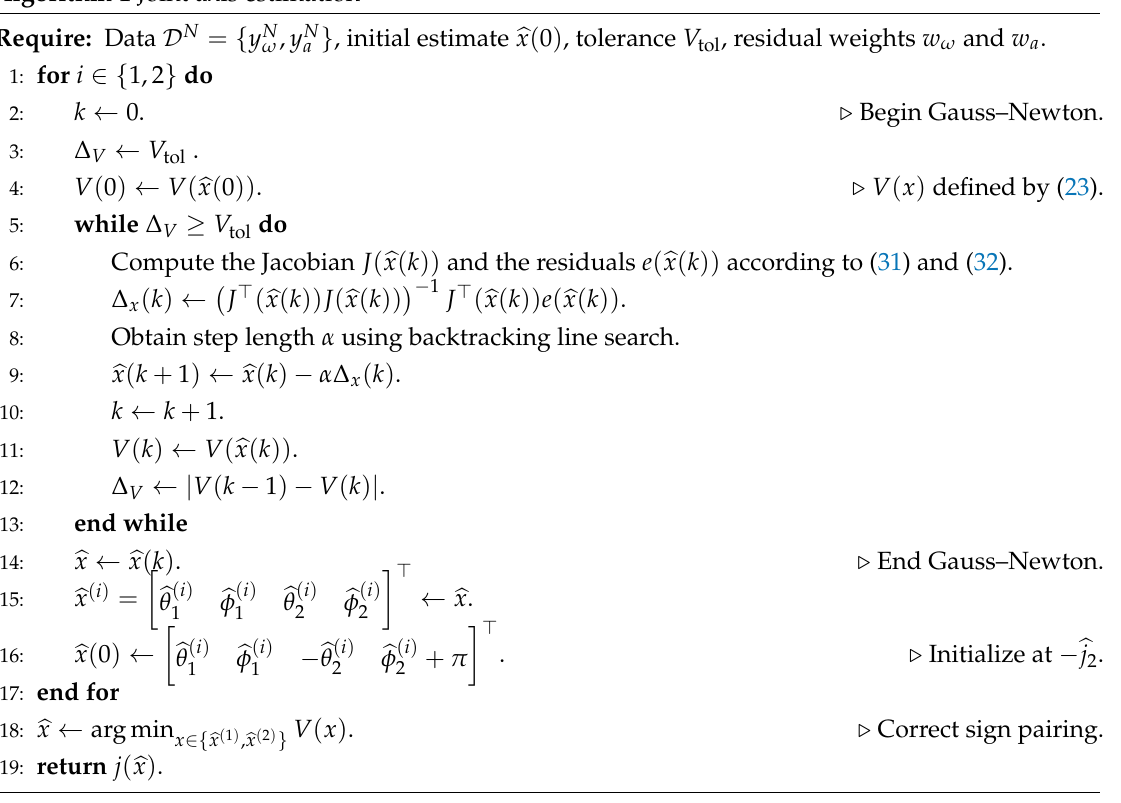
Algorithm 1 Joint axis